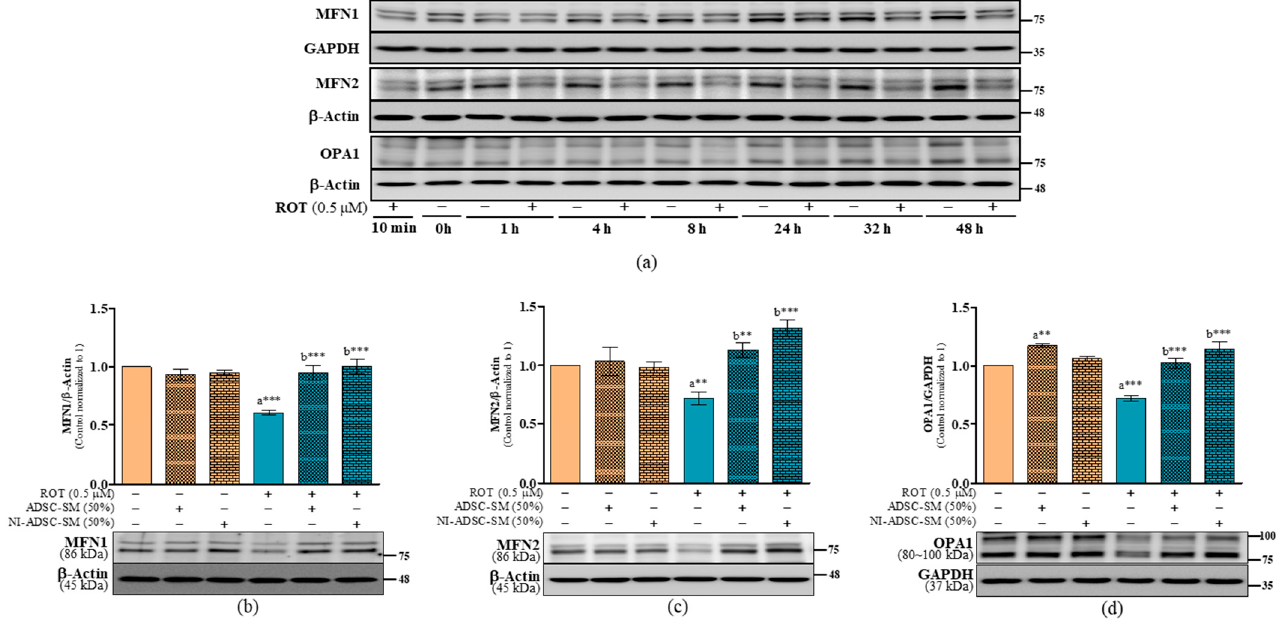
Figure 7. Effects of the NI-ADSC-SM on mitochondrial fusion-associated proteins. Cells treated with or without ROT (0.5 μ M) at different timepoints were assessed for MFN1, MFN2, and OPA1 expres- sion by Western blotting ( a ). Cells were incubated in the presence of ROT (0.5 μ M) or DMSO for 48 h alone or with the ADSC-SM or NI-ADSC-SM (each diluted by 50%) during the last 24 h. The levels of MFN1/ β -actin ( b ), MFN2/ β -actin ( c ), and OPA1/GAPDH ( d ) protein expression were assessed by Western blotting. Data are shown as the means (bars) and SEM (error bars) of three independent cell culture experiments. Statistical analysis was performed using one-way ANOVA with Tukey’s post-test. Statistical comparisons: a—compared with control; b—compared with ROT; ** p < 0.01 and *** p < 0.001.